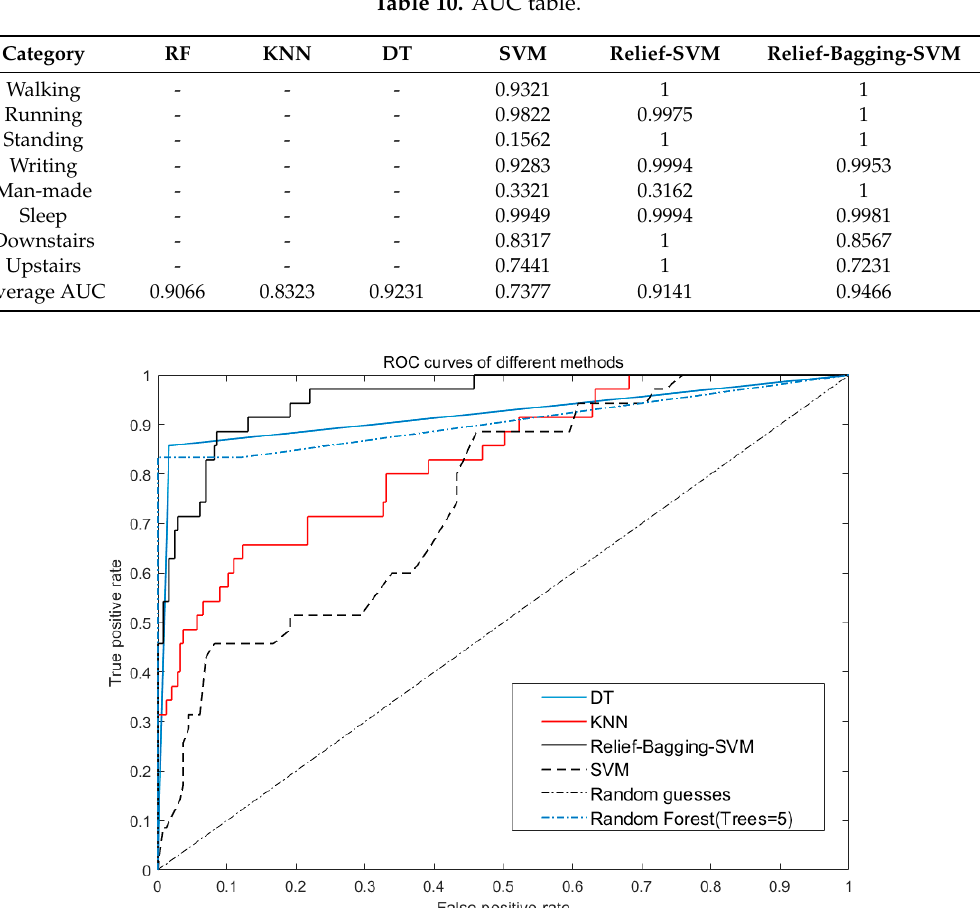
Figure 12. ROC curves of SVM, KNN, DT and Relief ‐ Bagging ‐ SVM.